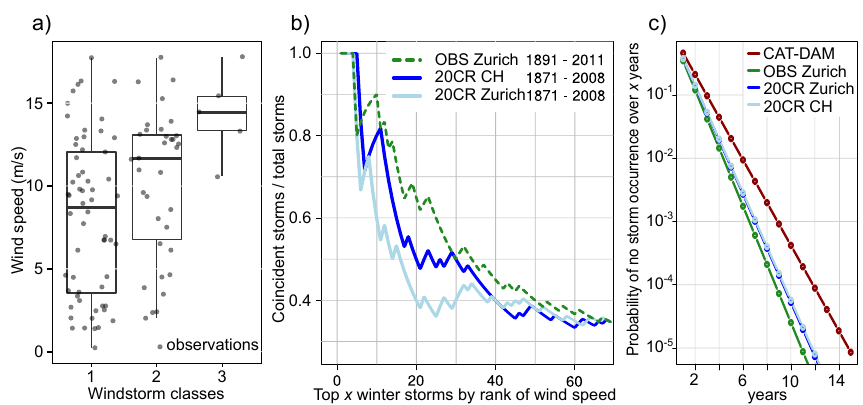
Figure 6. (a) Boxplots (box gives median and interquartile range, whiskers ± 1.5 × interquartile range) of the largest mean hourly wind speed at OBS Zurich (1891–2011, October to March; observations are represented as grey dots) as a function of windstorm class in CAT-DAM. (b) Ratio of coincidental windstorms to total windstorms ( y axis) as a function of the days with the highest wind speeds at OBS Zurich and in 20CR from October to March ( x axis). (c) Probability that no windstorms occurs during x years in the four considered windstorm series, assuming a Poisson point